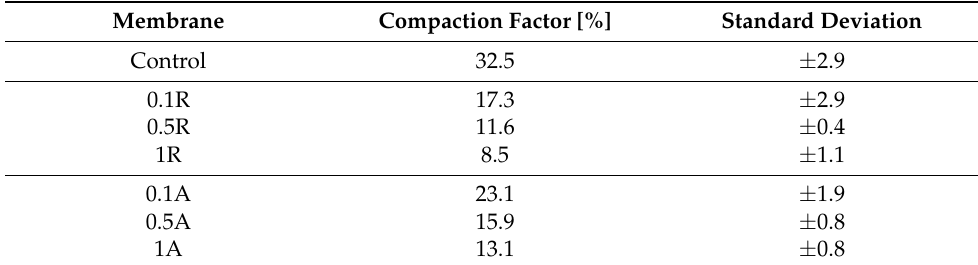
Table 6. Compaction degree during filtration for the studied